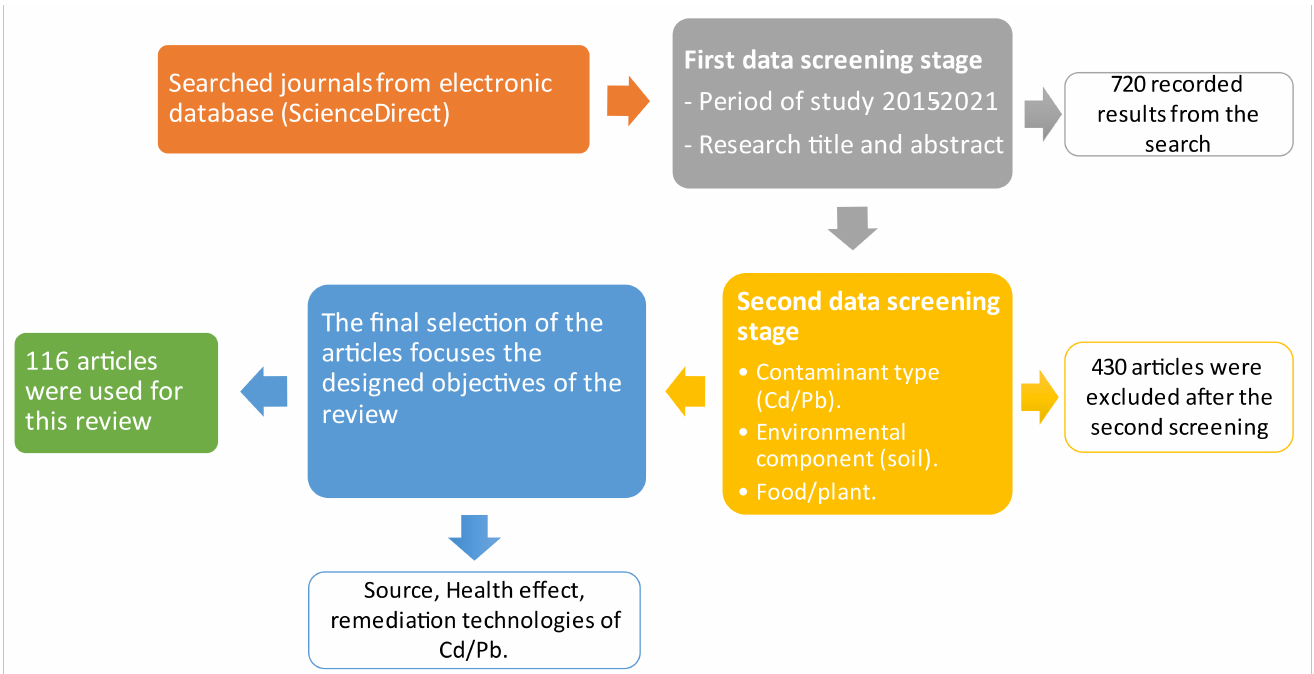
Figure 1. The process of selection of journal